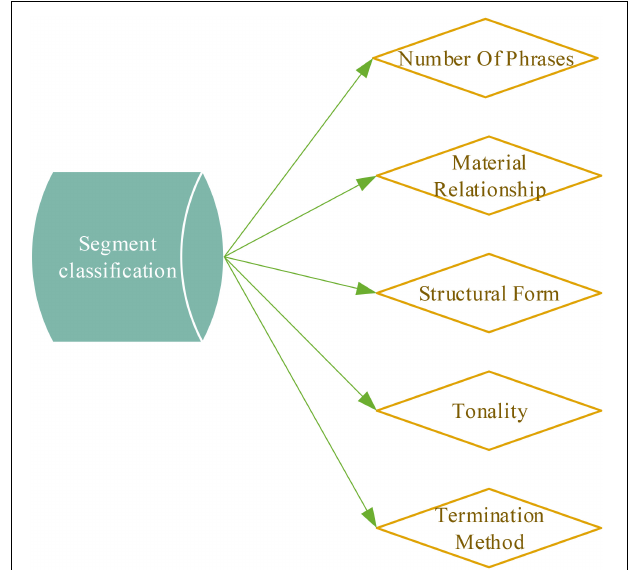
FIGURE 3 | Classification of